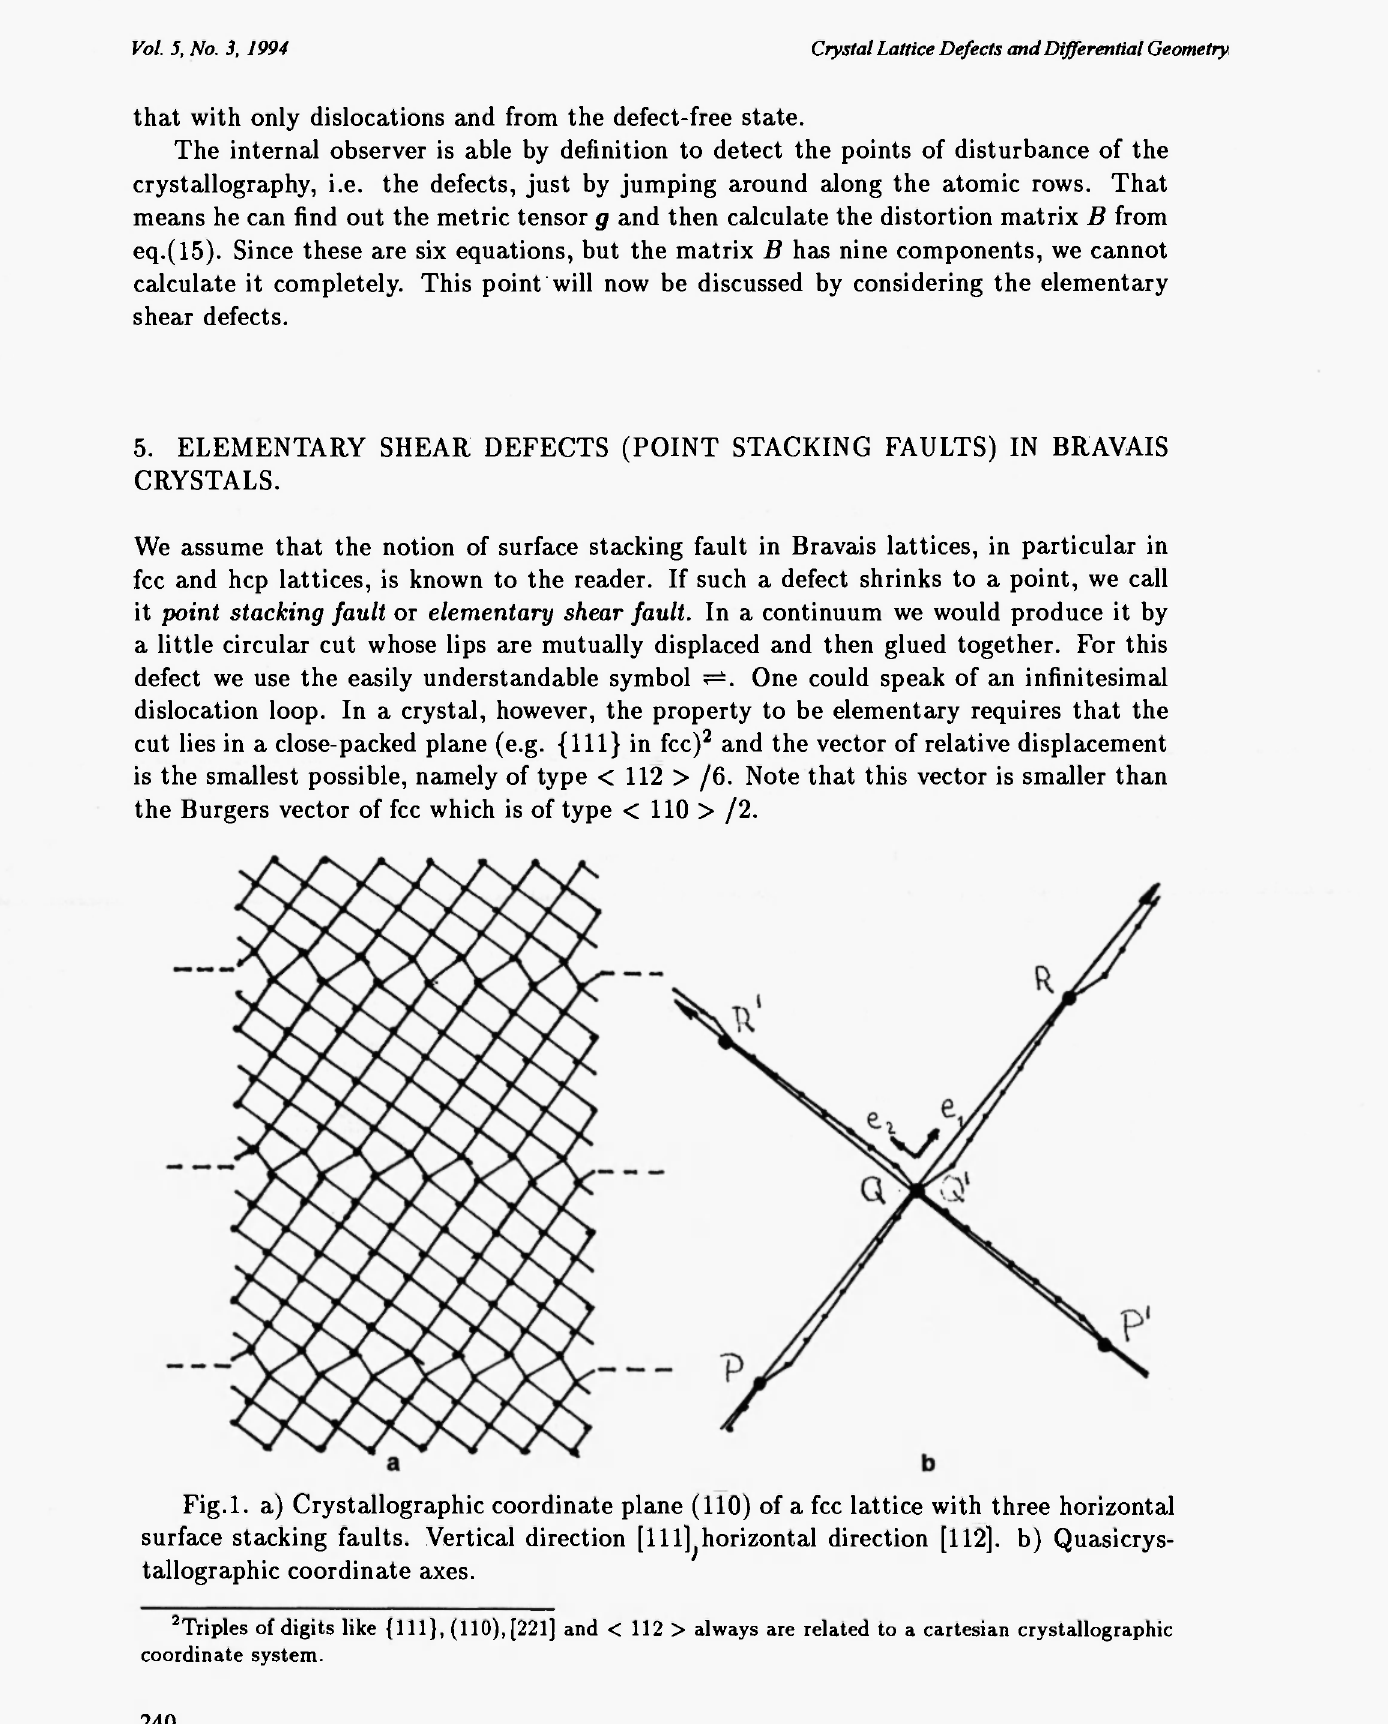
Fig.l. a) Crystallographic coordinate plane (110) of a fee lattice with three horizontal surface stacking faults. Vertical direction [111]^ horizontal direction [112]. b) Quasicrys- tallographic coordinate